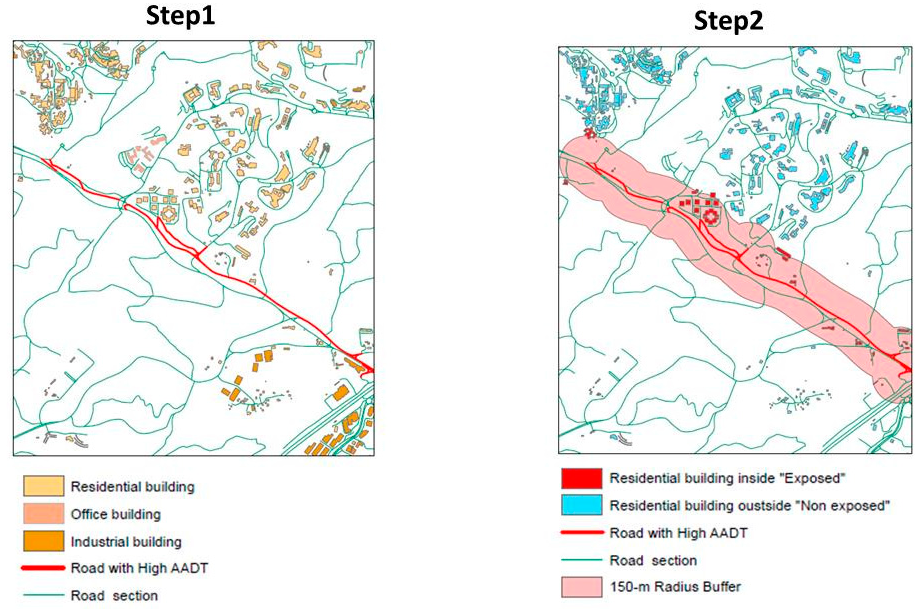
Figure 2. Description of the two successive and complementary steps required to estimate the heavy residential traffic exposure indicator.